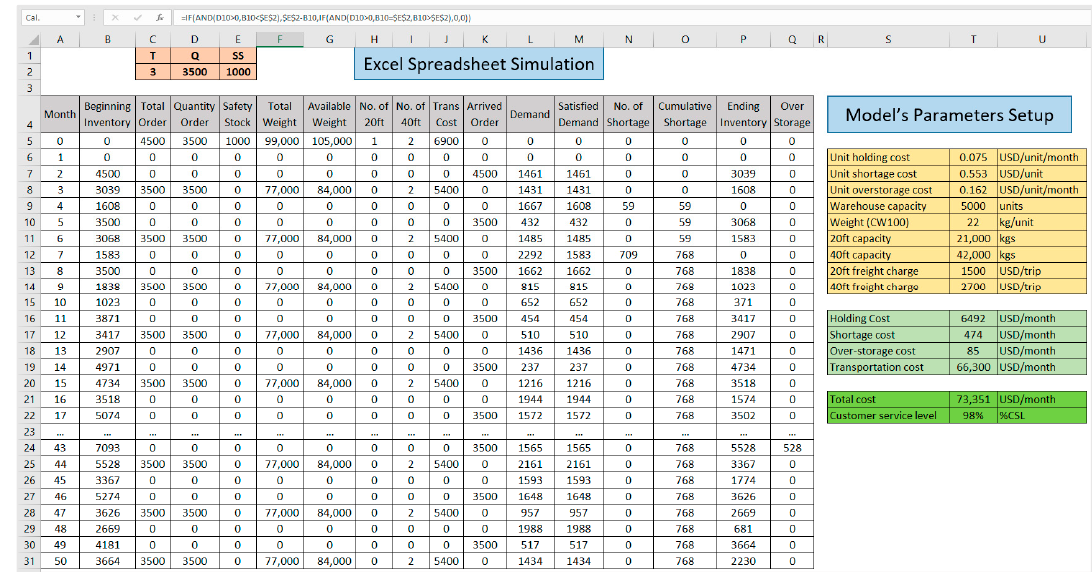
Figure 4. Excel spreadsheet simulation.